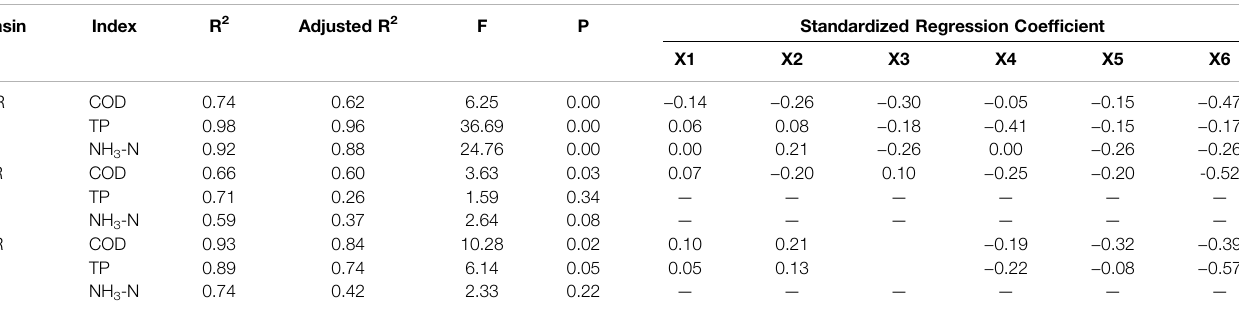
TABLE 5 | Ridge regression of the PIs and in fl uencing factors ( — indicates the model is not applicable: p > 0.05).